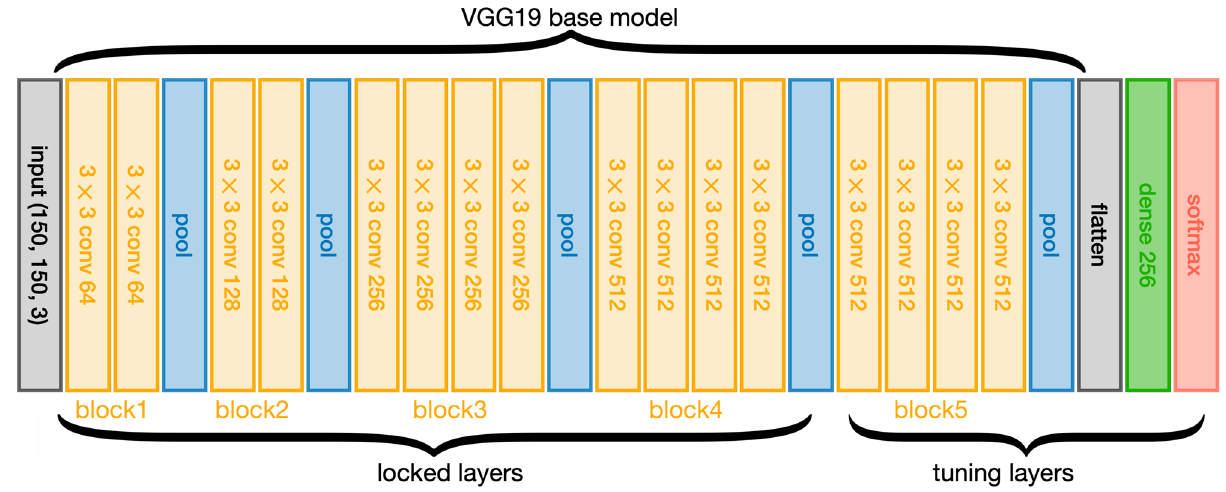
Figure 1. Structure of the transfer learning model . The input is (150, 150, 3), i.e. the image dimension is 150 by 150 pixels, with 3 channels. Convolutional layers are the yellow boxes with kernel size written in the front and number of kernels in the end; for example 3 × 3 conv 128 means kernel size is 3 by 3 pixels with a total of 128 kernels. Blue boxes are max pooling layers. Green box represents the fully connected dense layer with 256 neurons. Red box is the output layer with the softmax layer to output the classification results for the two